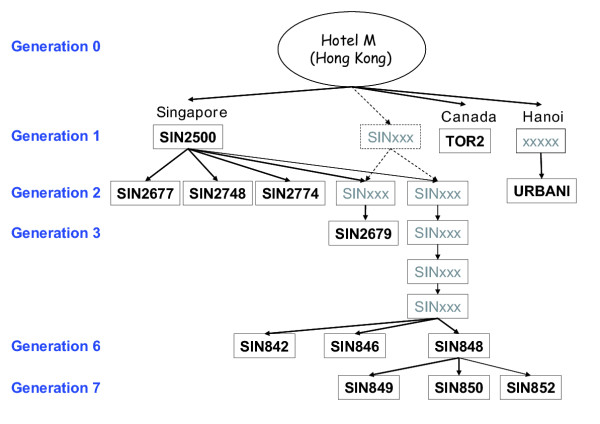
Relations between the Singapore patients and others related to Hotel M, Hong Kong. Contact tracing information of the Singapore patients and the two early reported SARS cases. Contact information revealed a single source of infection for Singapore patients, but molecular analysis, reported here and in (6), suggests the existence of an additional infection source (represented by dashed arrows and box) from the Hotel M case to Singapore.